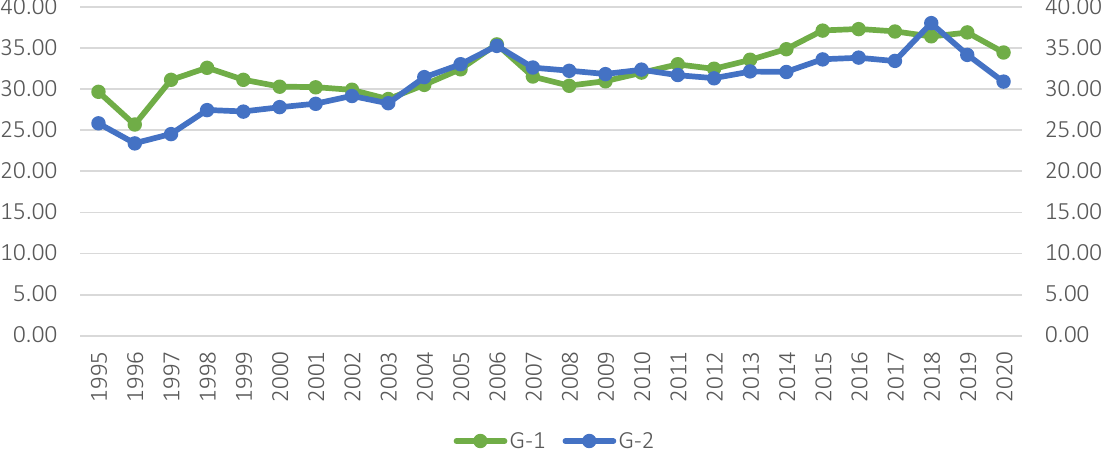
) and country`s inequality ( G 1